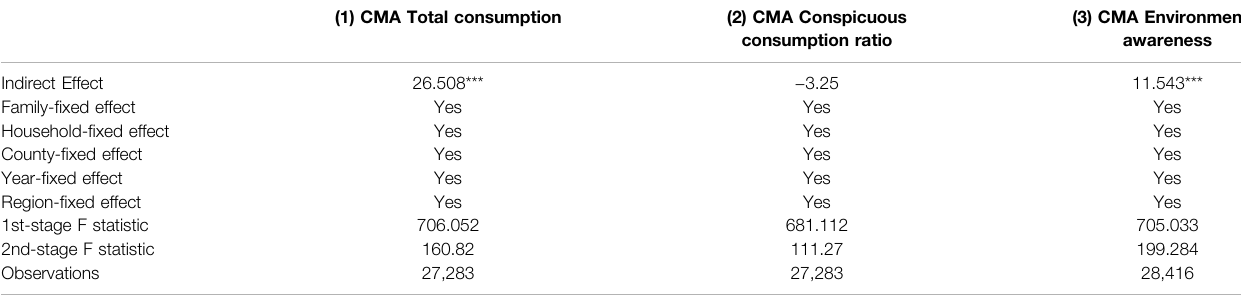
TABLE 5 | Estimation results: CMA model for mediator.